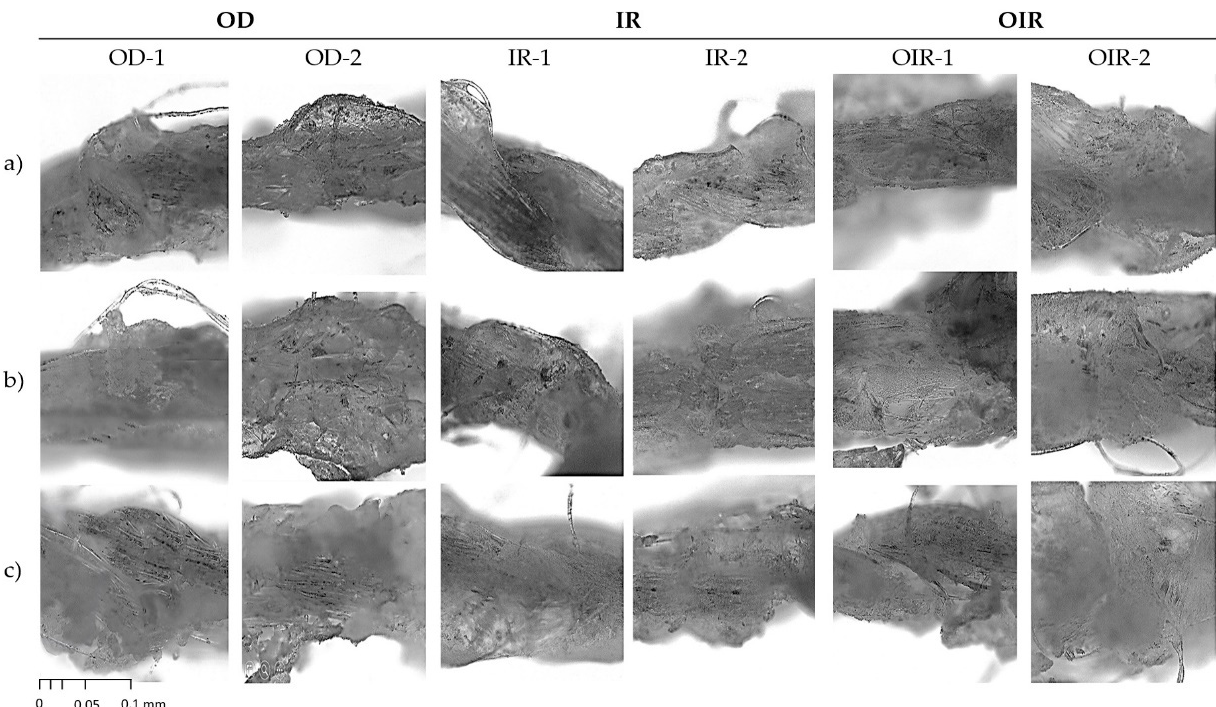
Figure 4. Uncoated cotton thread surface of ( a ) CT-A, ( b ) CT-B, and ( c ) CT-C.